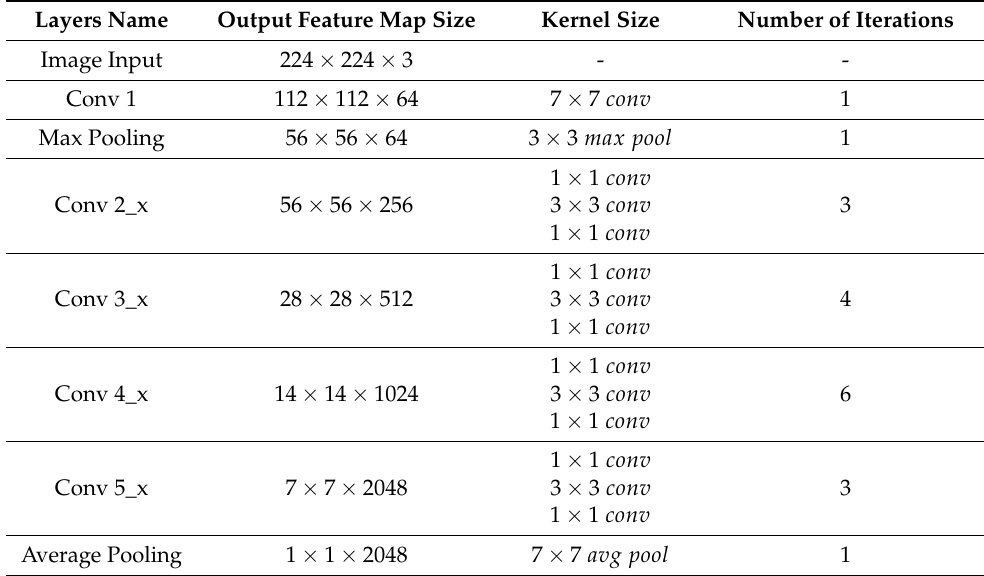
Table 2. Layer configuration details of modified